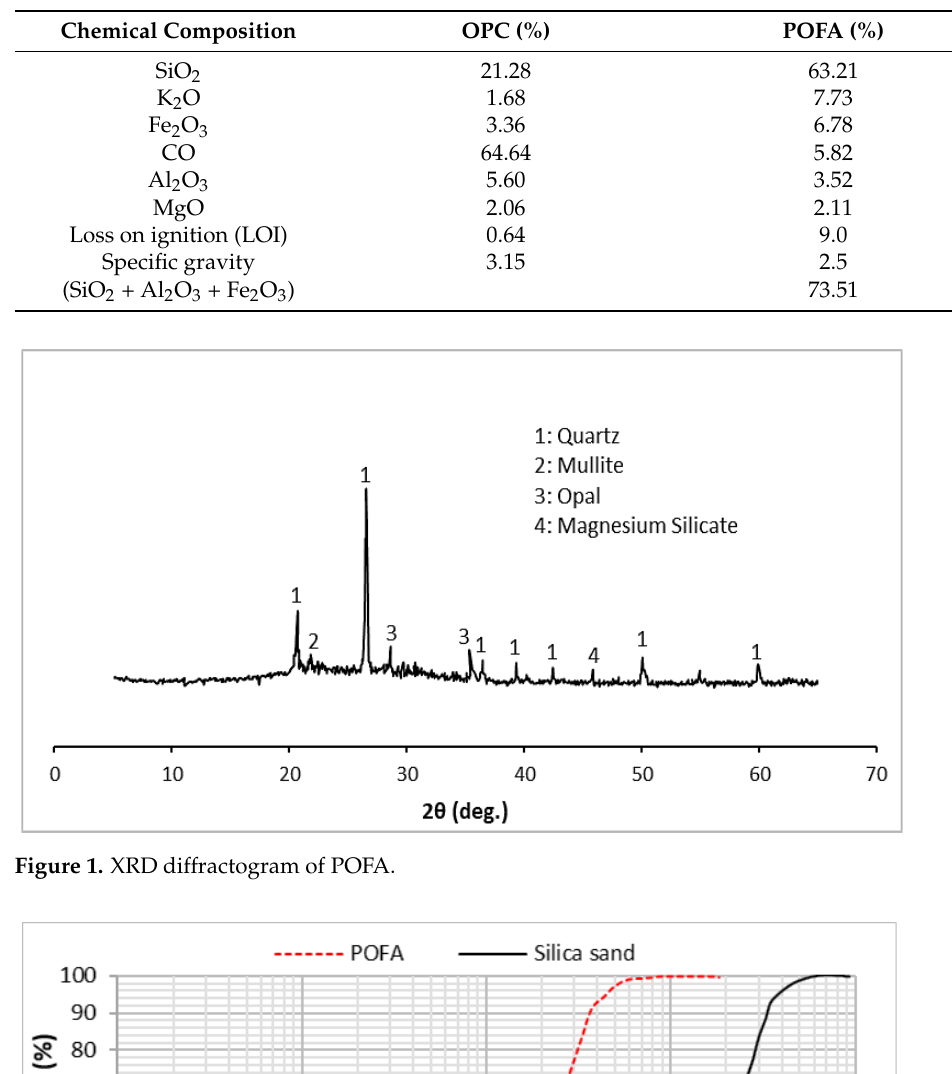
Table 1. Oxide composition of OPC and POFA.